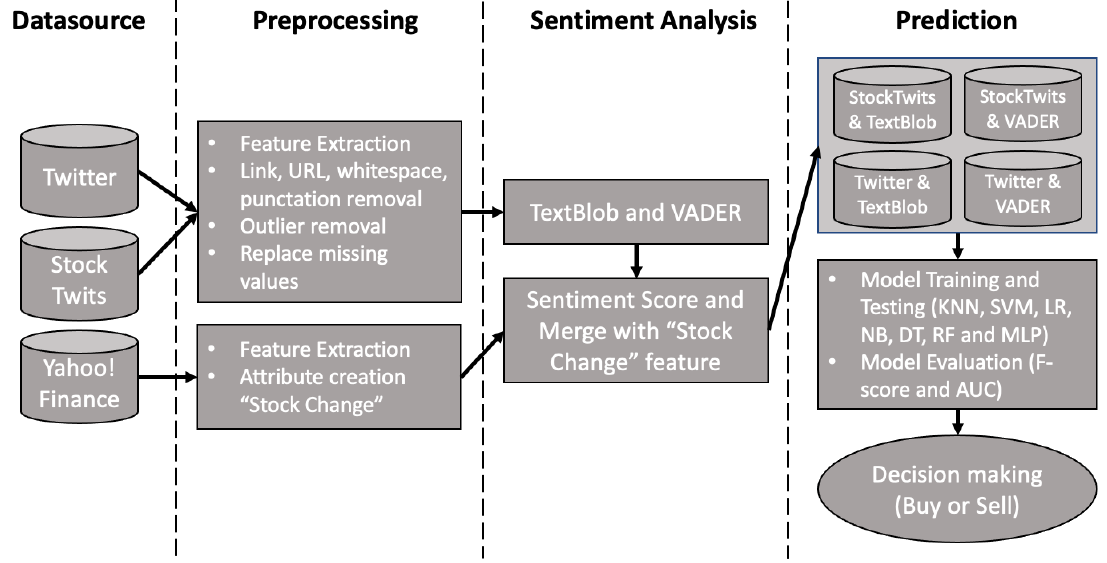
Figure 1. Flowchart of research